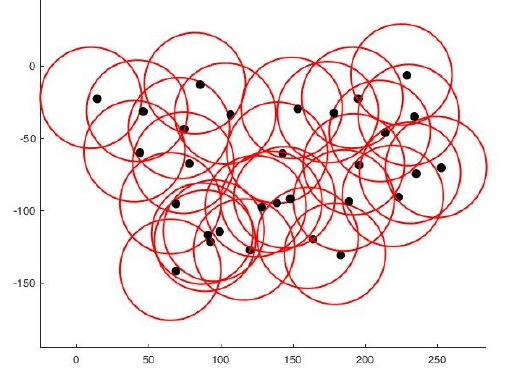
Figure 9. Sensors connectivity